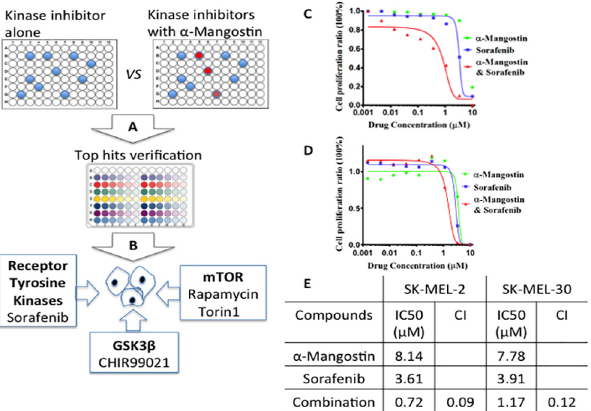
Fig 1. A cell proliferation based combination screening of α -Mangostin with kinase specific inhibitors. A and B, show the screening scheme of primary screening and hit identification on SK-MEL-2 cell line. C, The dosage dependent cell proliferation assay of drugs and drug combination on SK-MEL-2 cells. D, The dosage dependent cell proliferation assay of drugs and drug combination on SK-MEL-30 cells. E, Synergistic effect of drug combination. CI (Combination Index) value at half lethal dosage IC 50 indicated a strong synergistic effect of α -Mangostin and Sorafenib combination.